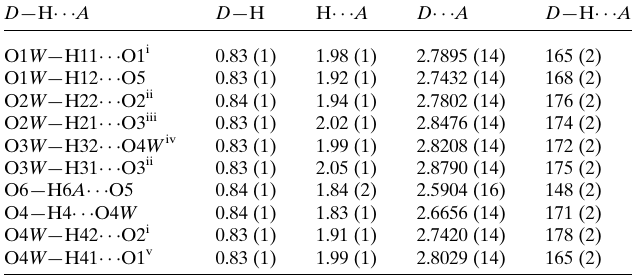
(Table 1, Fig. 3) involving the coordinated water molecules, non-coordinated water molecules, and sulfonate and carboxylate groups. All of the water and carboxylate H atoms participate in such an intermolecular hydrogen bond, while each of the sulfonate and unprotonated carboxylate O atoms function as hydrogen-bond acceptors. The hydroxyl group participates only in an intramolecular hydrogen bond with the adjacent carboxylate O atom (shown in Fig. 1).